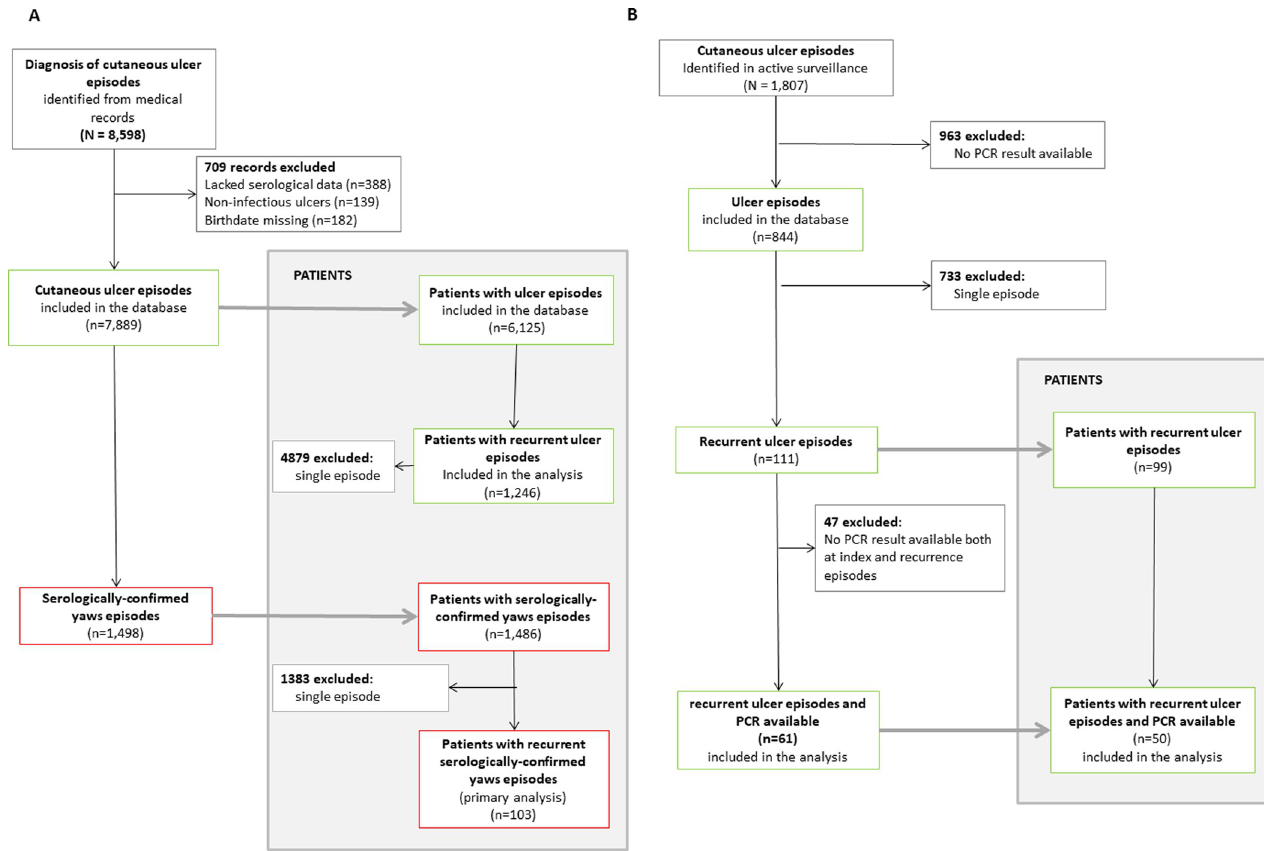
Fig 2. Study profile A: Passive case detection through hospital records review; cases were confirmed by a serological test. B: Active case detection in mass drug administration setting; cases were confirmed by PCR.